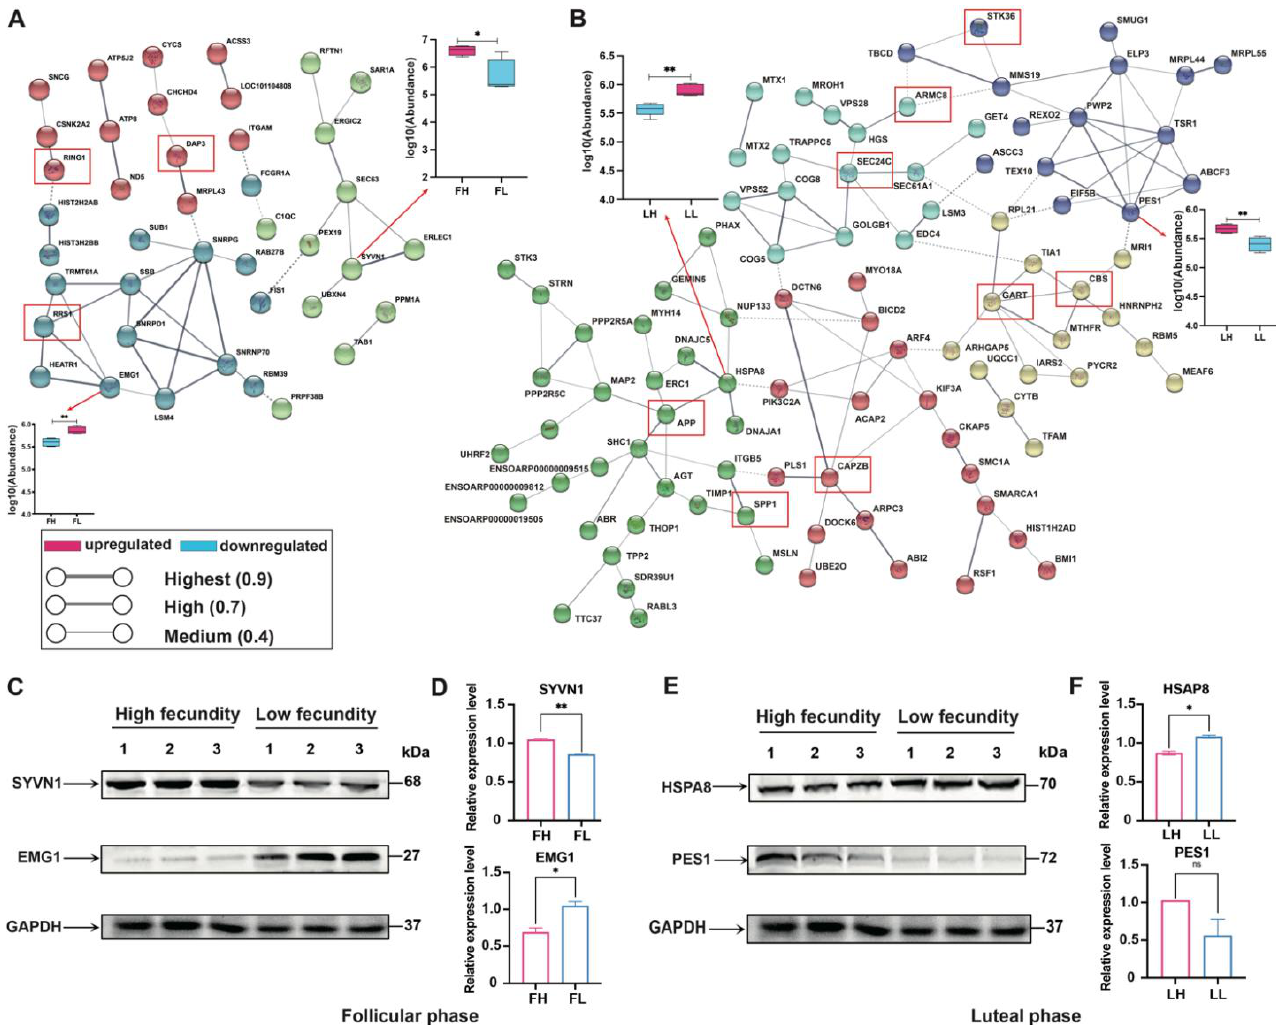
Figure 6. Protein – protein interactions (PPI) network and Western blot analyses of hub DAPs. (A and B) PPI analysis of the DAPs was conducted based on the STRING database (https://www.string-db.org/, accessed on 10 May 2022) in FH vs. FL ( A ) and LH vs. LL ( B ) comparison groups; we selected a confidence score of >0.4 to construct the PPI network; Nodes represent proteins, edges denote the predicted functional associations. Box plots of proteins SYVN1, EMG1, HSPA8, and PES1 are shown. Western blot analysis of SYVN1 and EMG1 in the follicular phase ( C , D ), and HSPA8 and PES1 in the luteal phase ( E , F ), and the reference protein GAPDH. * Presents significant difference at p < 0.05, ** presents significant difference at p <